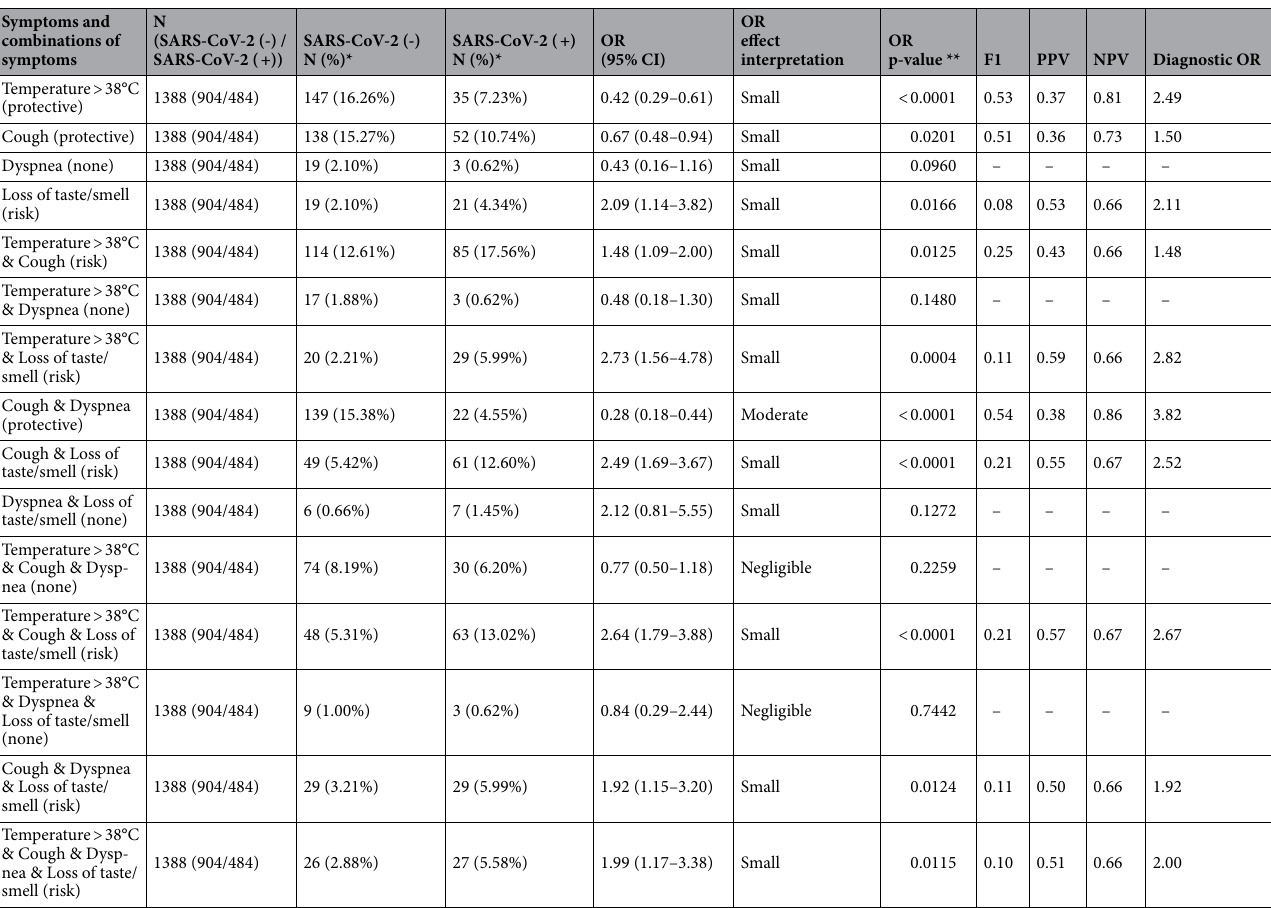
Table 4. The differences in occurrence and co-occurrence of chosen symptoms between patients positive and negative for SARS-CoV-2 and the quality indices for the logistic regression based predictor (derived from